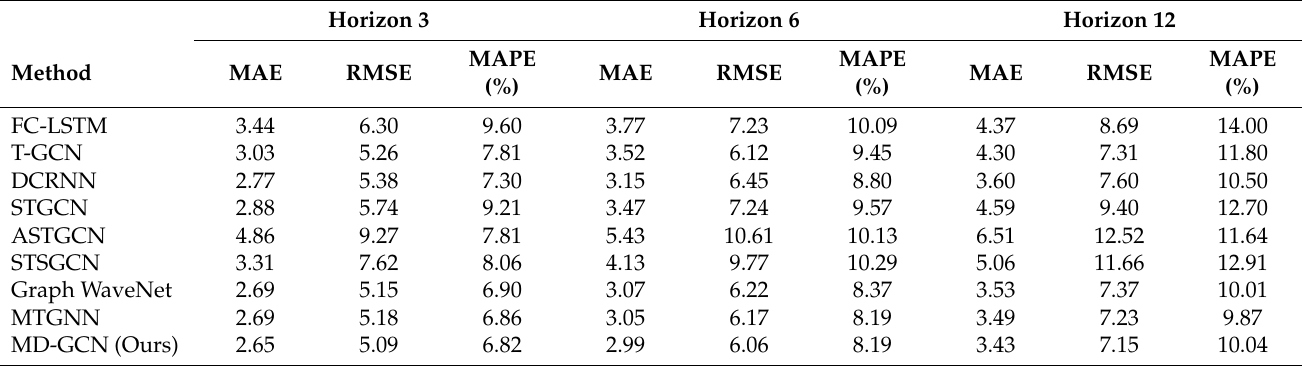
Table 3. The comparative results on METR-LA.